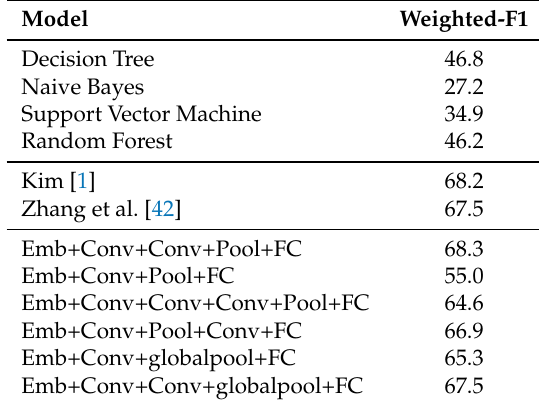
Table 5. Performance of ternary classification with the MR data, where Emb, Conv, Pool, globalpool, FC stand for embedding layer, convolutional layer, pooling layer, global pooling layer, and fully-connected layer,